Question: Write a single sentence explaining what this figure depicts.
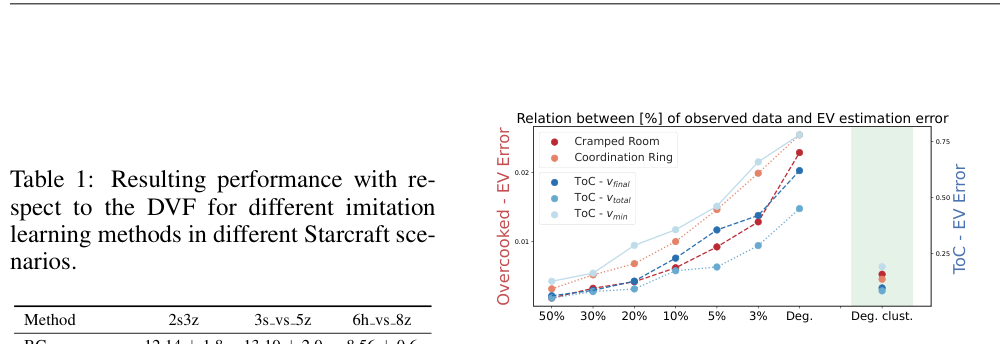
Answer: Mean error in estimating EVs with decreas- ing number of observations. ‘Deg.’ refers to the fully anonymized degenerate case. Error decreases signif- icantly if agents are clustered (green-shaded area).